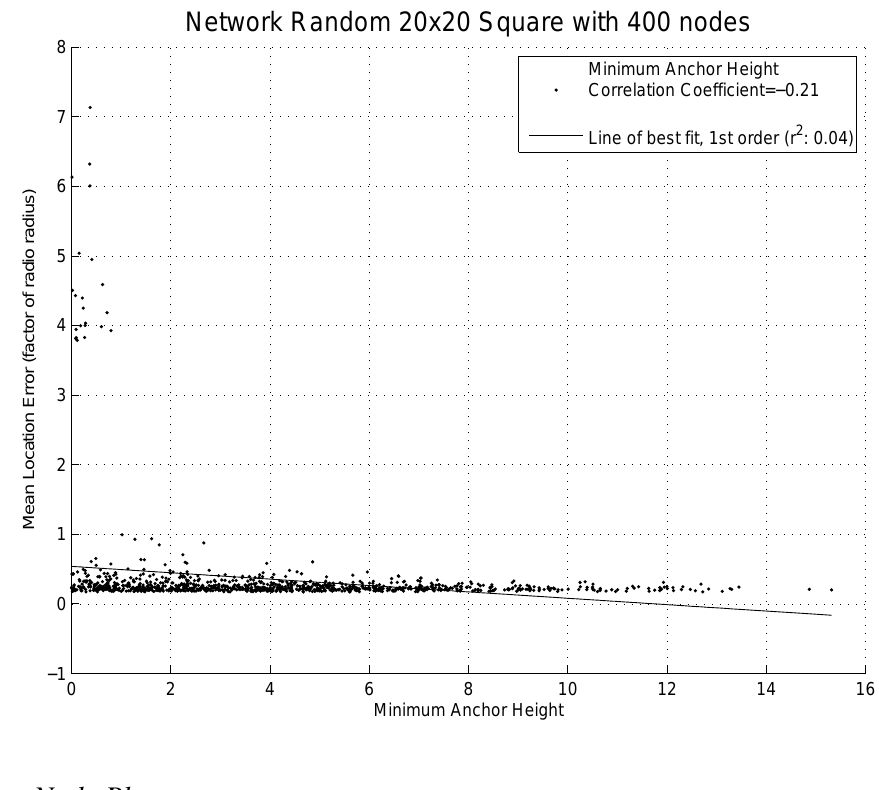
Figure 3. Minimum height of anchor triangle vs . localization